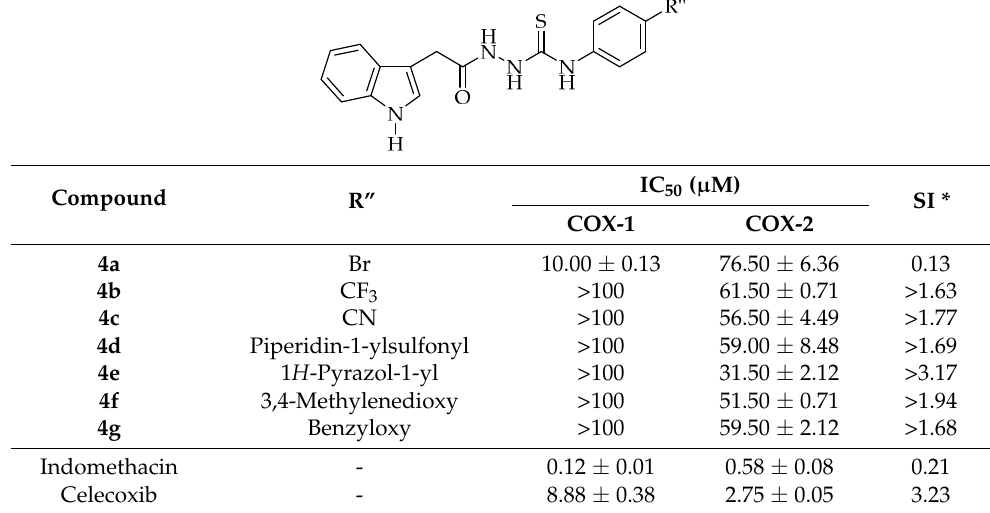
Table 2. COX inhibitory profiles of compounds 4a-g and positive controls.